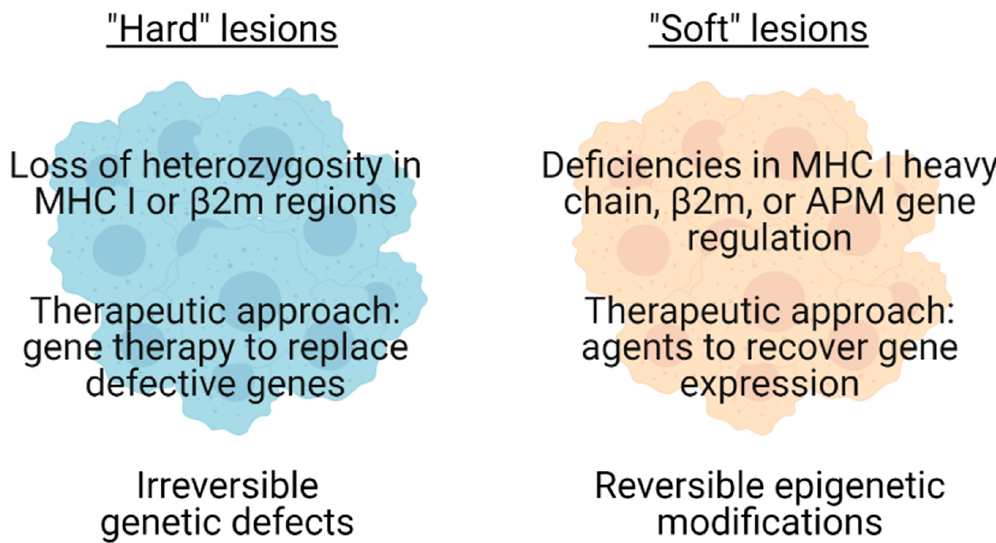
Figure 1. MHC I aberrations in cancer. Tumours can be categorised into “Hard” or “Soft” lesions based on the nature of MHC I defects [19]. Mutations, deletions, or loss of heterozygosity result in irreversible structural defects in the MHC I pathway and can be categorised as “Hard” lesions. Downregulation or inhibition of gene expression result in reversible regulatory defects in the MHC I pathway and can be categorised as “Soft” lesions. Therapeutic approaches differ according to lesion type.